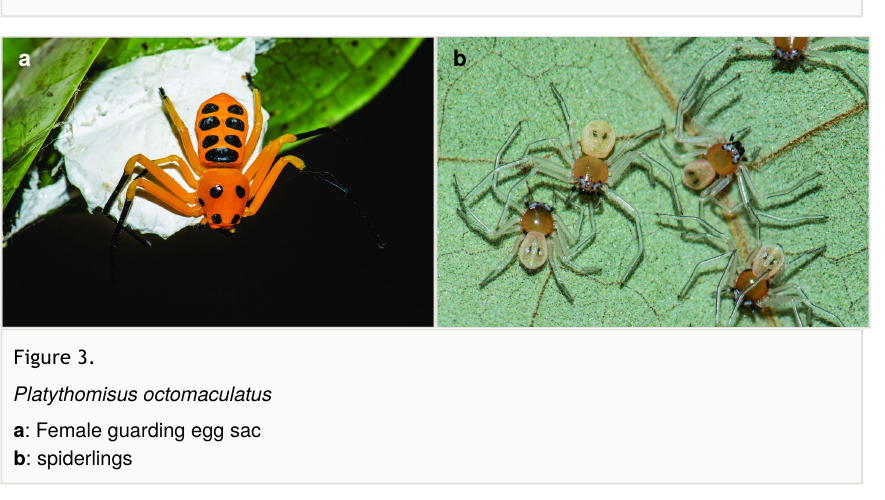
Figure 2. Platythomisus octomaculatus , abdominal spots (left to right) before egg laying, just after egg laying, late after egg laying